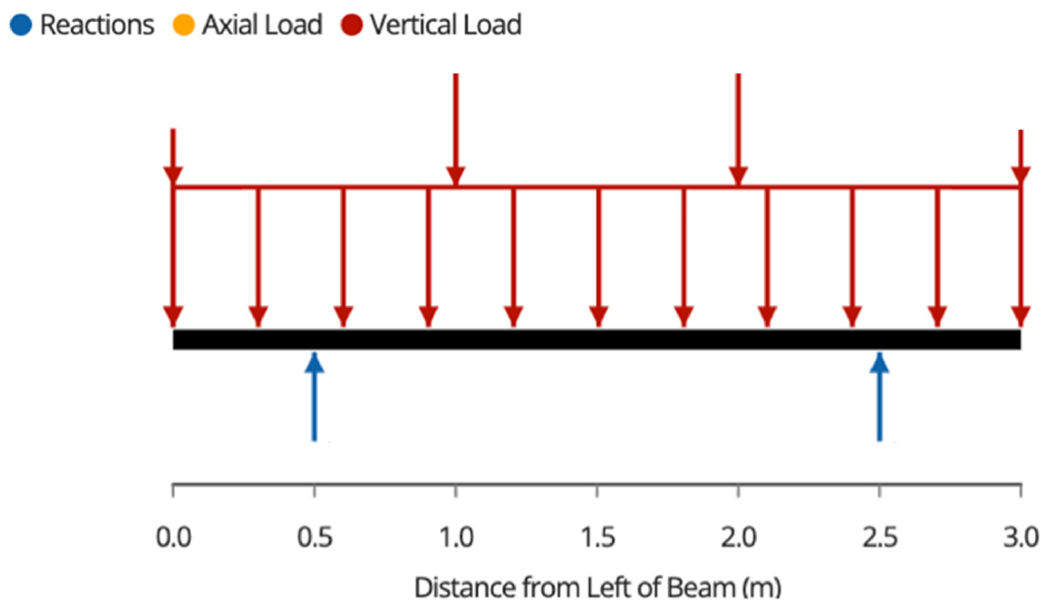
Figure A5. Beam Free-Body Diagram.